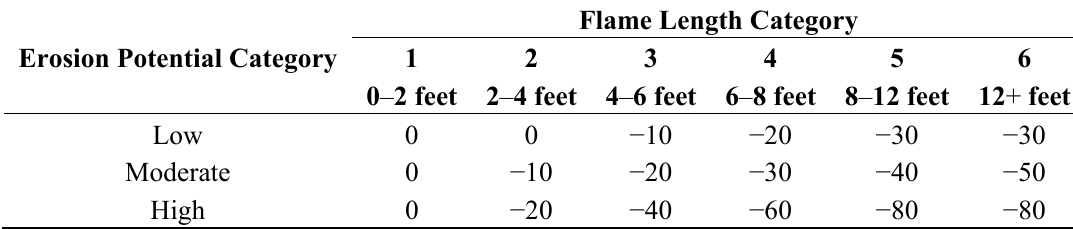
Table 1. Expert-defined response functions for fire effects to watersheds and surface drinking water quality. Numerical quantities in the table represent relative percentages of net value change for each erosion potential and flame length